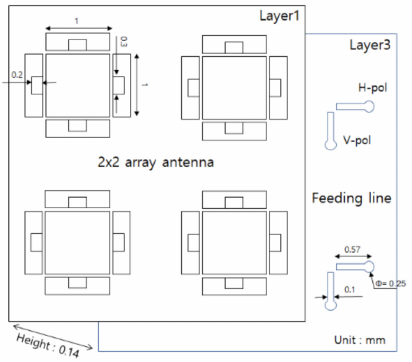
Figure 7. Design results of the designed antenna and feeding line.